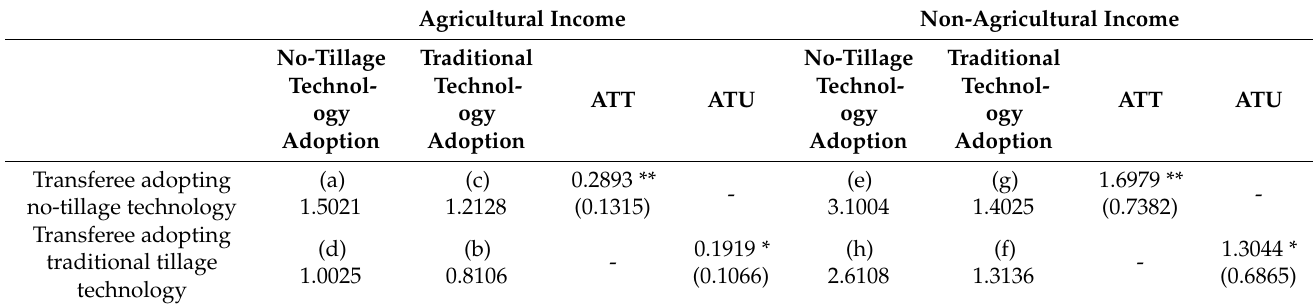
Table 3. The average treatment effect of ESR